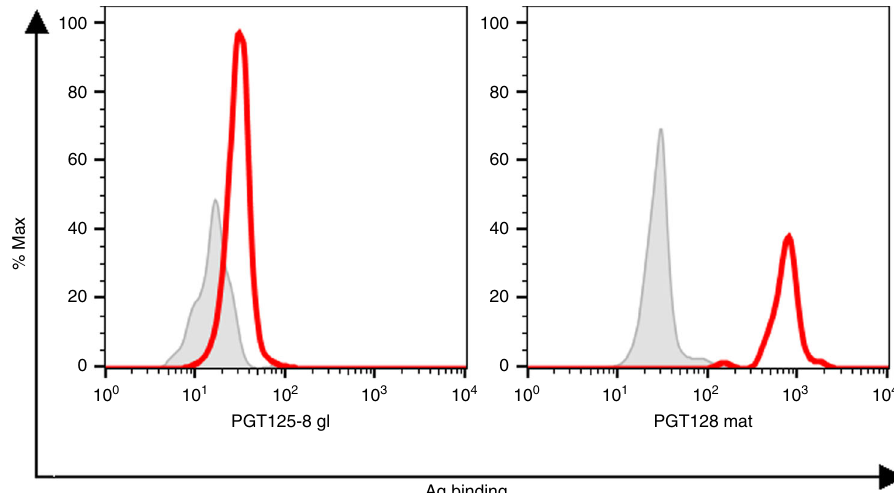
Fig. 4 The gl precursor of the PGT128/130 families binds the lead NIT82B glycoconjugate. Binding of the predicted gl antibody was determined by fl ow cytometry using a biotinylated version of the lead conjugate NIT82B (designated NIT150b). Shown is the binding of the gl precursor (left) and of the af fi nity-matured PGT128 antibody (right), as a control, to NIT150b at 1 µ M. Bound antigen was detected with PE-conjugated streptavidin and antigen binding gated on the live, antibody-expressing cell populations, which were detected with an APC-conjugated anti-human F(ab ‘ ) 2 -speci fi c antibody. The greyed histograms represent glycoconjugate binding to cells transfected with the HIV bnAb VRC01, which is speci fi c for the CD4-binding site of HIV Env. The results are from a single